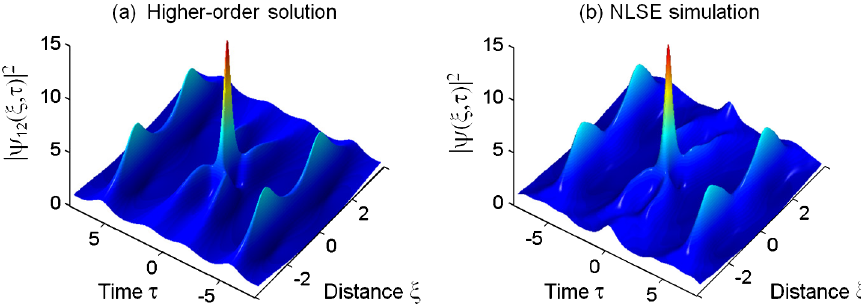
FIG. 3. Collision of two Akhmediev breathers ( a 1 ¼ 0 : 14 and a 2 ¼ 0 : 34 ). (a) Corresponding higher-order solution derived from Darboux transformations [see Eq. (3)]. (b) NLSE simulation: Evolution of the superposition of two ideal ABs calculated at arbitrary optimized distances to excite the AB collision. Note that only one period in time is plotted and that initial conditions are arbitrarily injected at (cid:1) 0 ¼ (cid:1) 4 to get the collision at the origin.